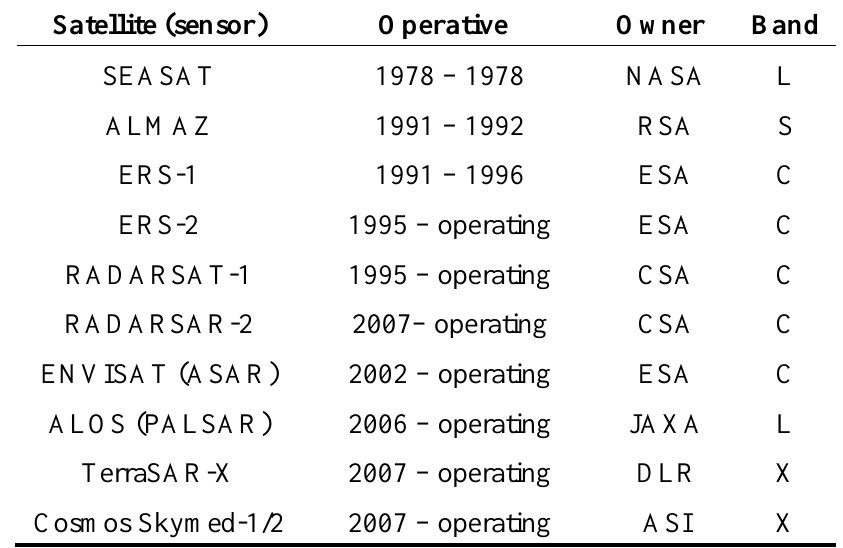
Table 1. Satellites carrying SAR instruments focusing in ocean observation.